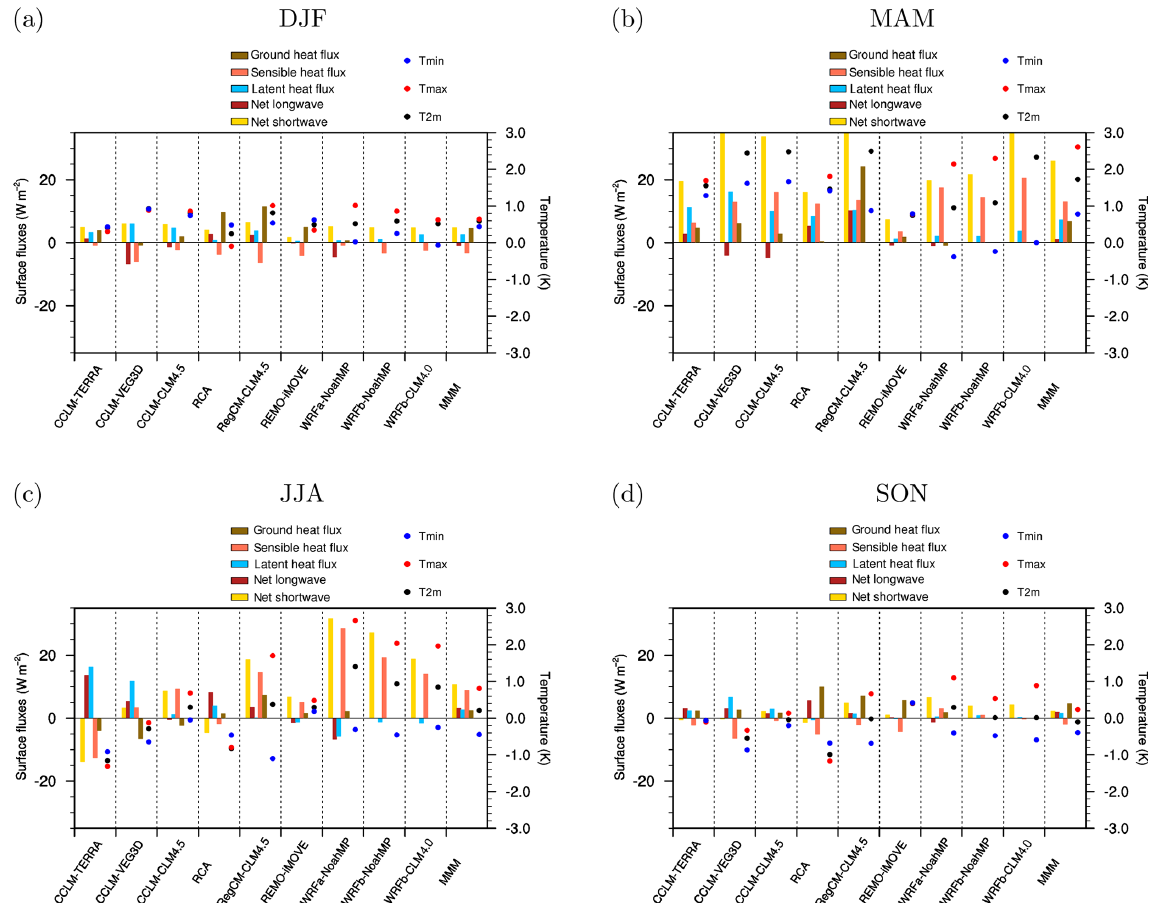
Figure 9. Changes in temperature and in surface energy balance components (FOREST minus GRASS) averaged over Scandinavia for DJF, MAM, JJA and SON. Results for other regions are shown in the